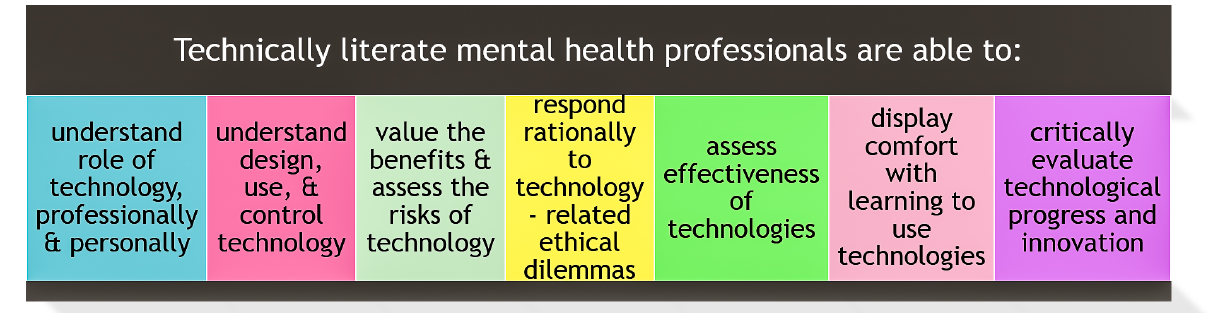
Figure 7. Abilities of technically literate health professionals. From Using Technology to Improve Counseling Practice, A Primer for the 21st Century